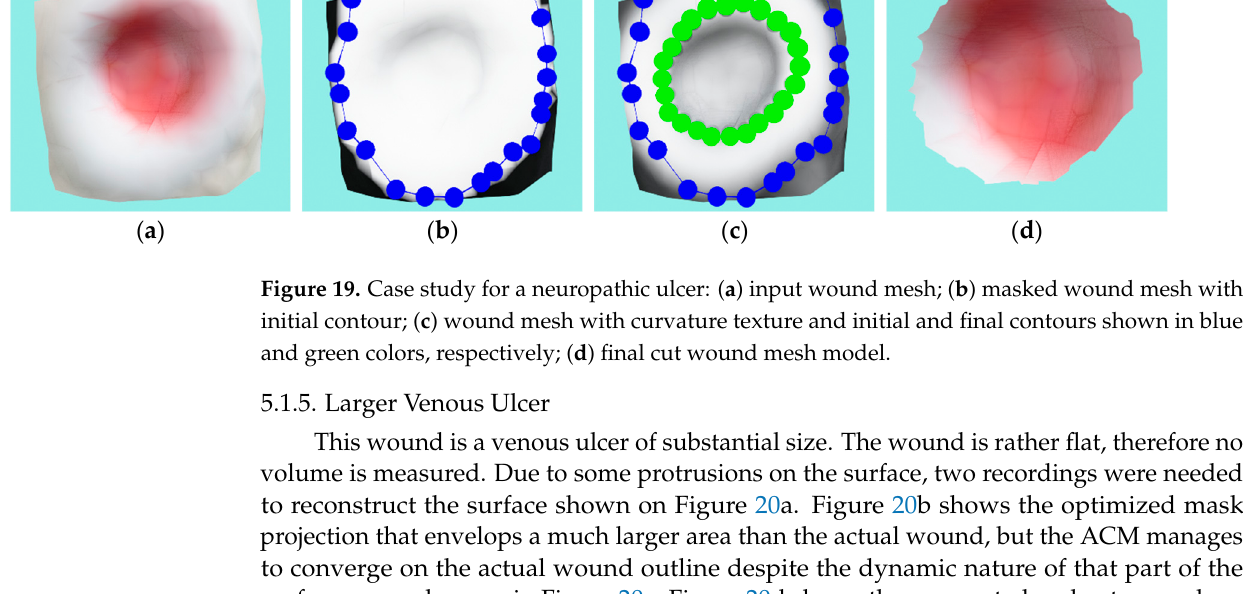
Figure 19. Case study for a neuropathic ulcer: ( a ) input wound mesh; ( b ) masked wound mesh with initial contour; ( c ) wound mesh with curvature texture and initial and fi nal contours shown in blue and green colors, respectively; ( d ) fi nal cut wound mesh model.